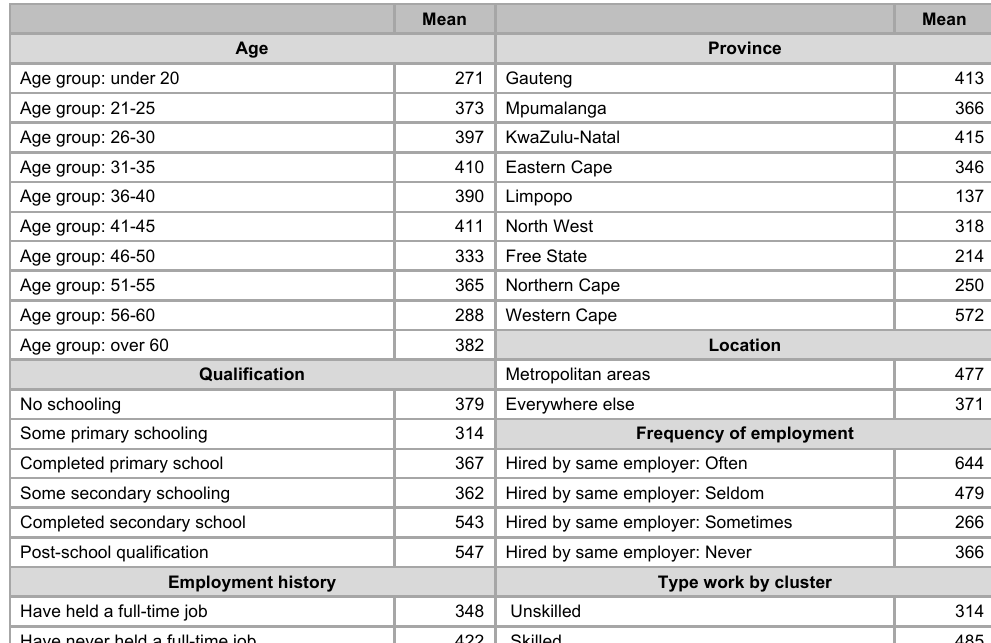
Means of earnings in a good week, in